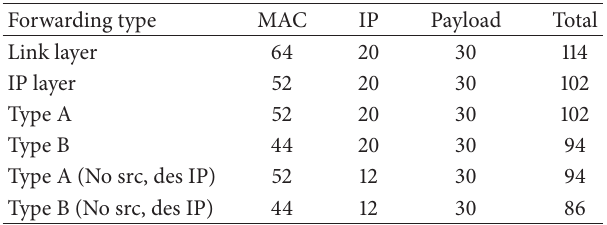
Table 4: Data packet comparison using different